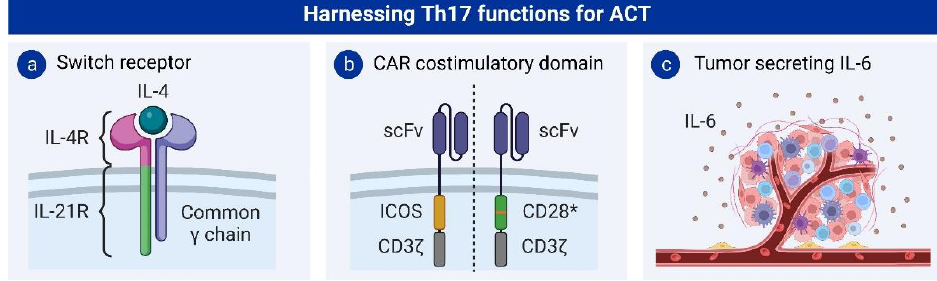
Figure 4. Strategies harnessing Th17 functions in ACT: ( a ) Chimeric cytokine receptor formed by the extracellular domain of the IL-4R and the intracellular domain of the IL-21R, which dimerizes with the common γ chain. ( b ) Using ICOS or mutating the CD28 costimulatory domain (CD28*) polarizes CAR T cells towards a Th17 phenotype. ( c ) Engineering of TGF- β -producing cancer cells to secrete IL-6 skews T-cell polarization towards Th17. scFv: short-chain variable